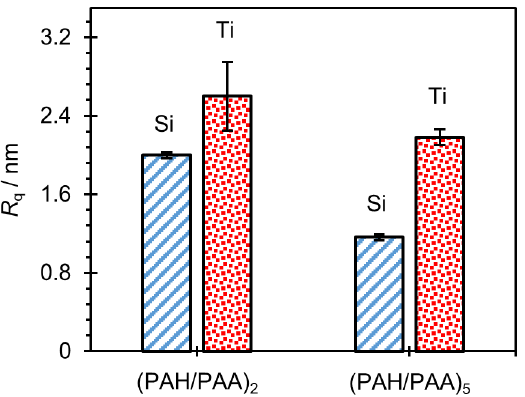
Figure 9. Root mean square surface roughness ( R q ) obtained for silicon and titanium surfaces coated with 2 or 5 PAH/PAA bilayers.